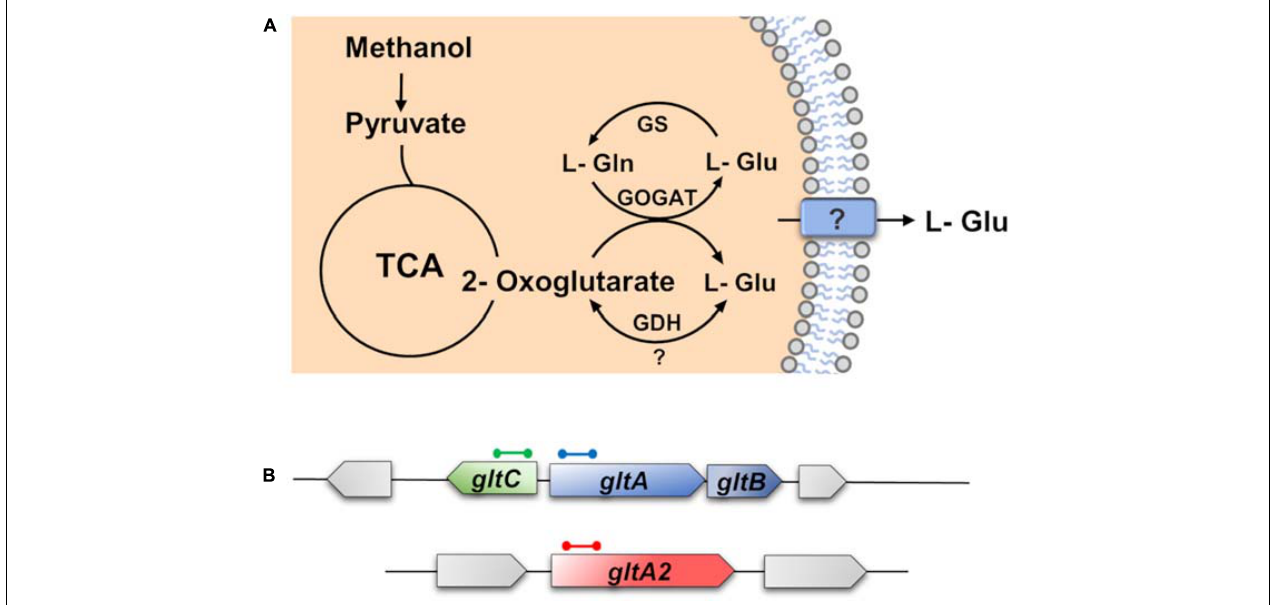
FIGURE 4 | Schematic overview of the synthesis and degradation of L-glutamate by Bacillus methanolicus MGA3. (A) The 2-oxoglutarate and L-glutamine are converted to L-glutamate by the L-glutamate synthase (GOGAT) [ via the GltAB and GltA2 enzymes (Krog et al., 2013) ] and most of it is excreted by B. methanolicus MGA3 through an unknown transporter, or channel protein. In addition, L-glutamate can be synthesized by the glutamate dehydrogenase (GDH) or can be catabolically degraded by the GDH (Krog et al., 2013). This reaction is dependent on the affinity of the GDH to ammonia, 2-oxoglutarate, and L-glutamate. L-glutamate can also be degraded by the glutamine synthetase (GS) to L-glutamine. (B) Genetic organization of the L-glutamate synthesis genes (GOGAT) encoded by the gltAB operon and of gltA2 , and of the regulatory gene gltC . The genetic organization of the gltAB , gltC, and gltA2 structural genes and their genome neighborhood was deduced from the B. methanolicus MGA3 genome sequence (Heggeset et al.,